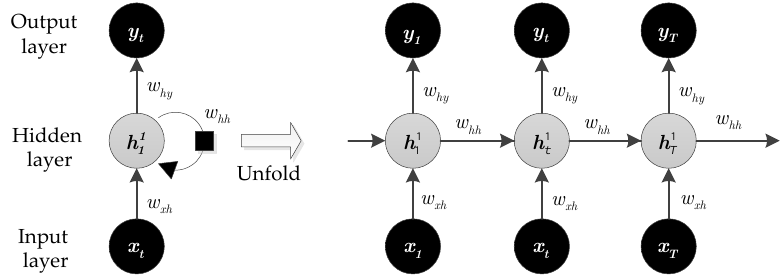
Figure 2. Recurrent neural network (RNN). The circles represent network layers and the solid lines represent weighted connections. The arrows show the direction of forward propagation.